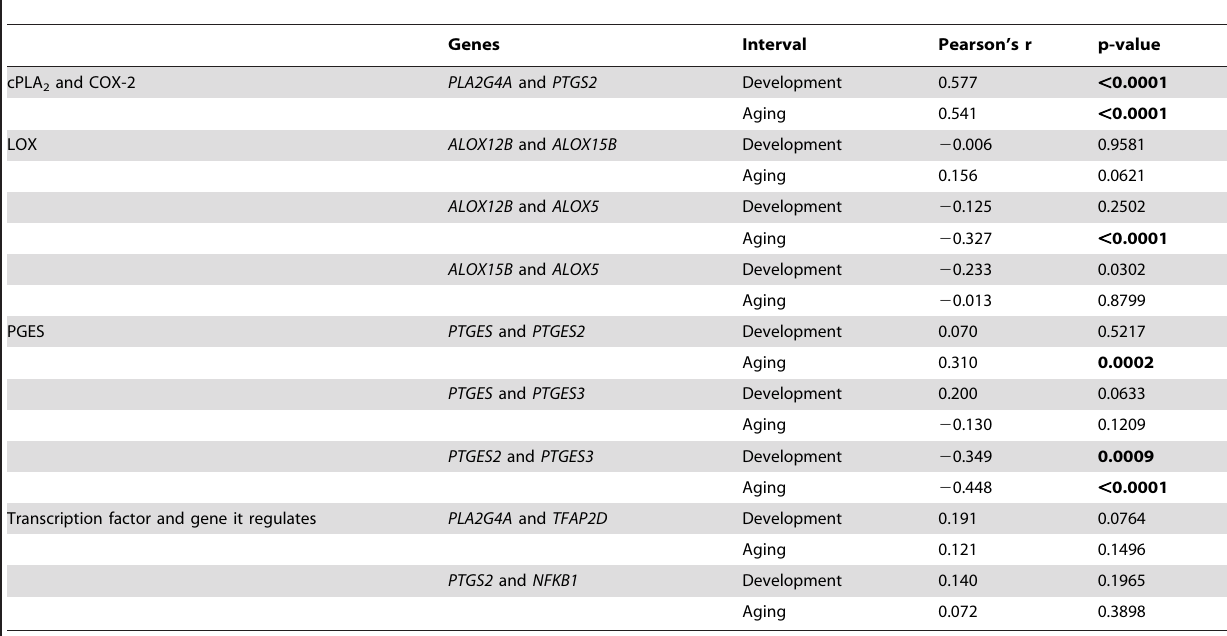
Table 3. Correlations between expression levels of functionally coupled enzymes.